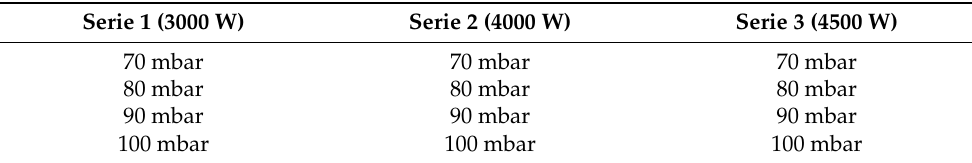
Table 1. Experimental series and the corresponding growth